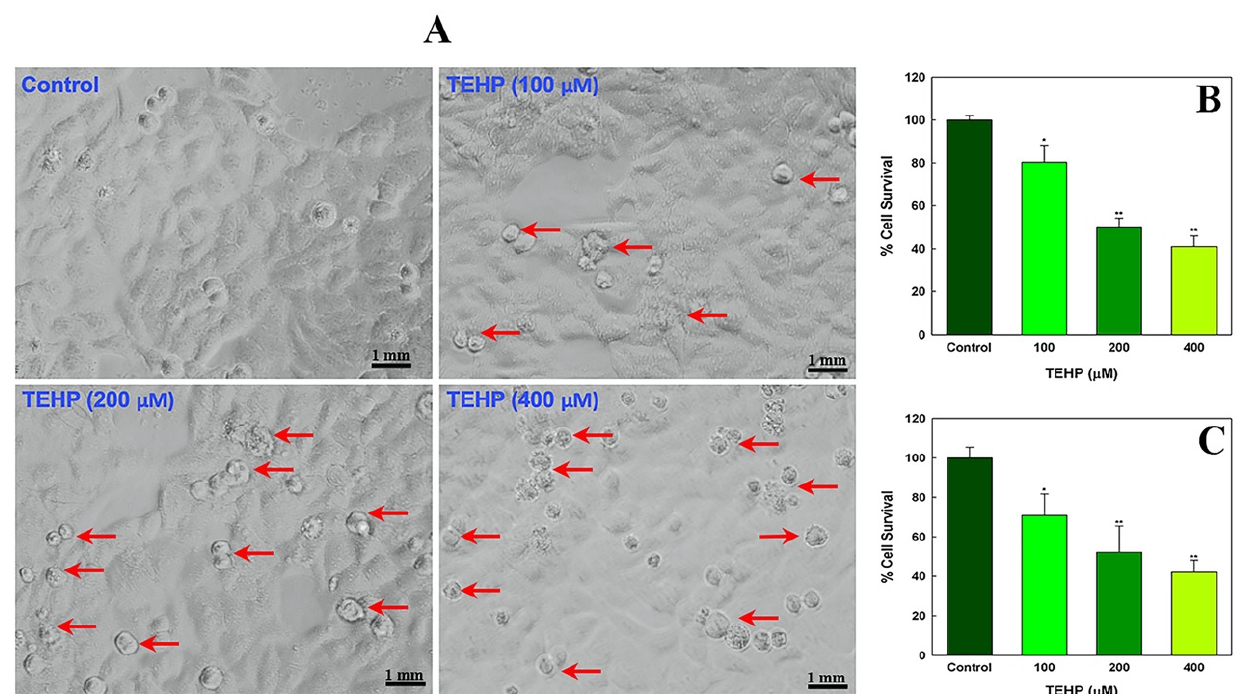
Figure 1. Cytotoxic effects of TEHP in HepG2 cells. ( A ) TEHP-induced structural changes in HepG2 cells after 72 h. Photomicrographs were taken at 20 × . ( B ) Mitochondrial dehydrogenase-based cytotoxicity quantification by MTT assay, and ( C ) lysosomal membrane fragility-based NRU assay, indicating lysosomal toxicity. Morphological changes, dead cells are indicated with arrows. * p < 0.05, ** p < 0.01 versus control.